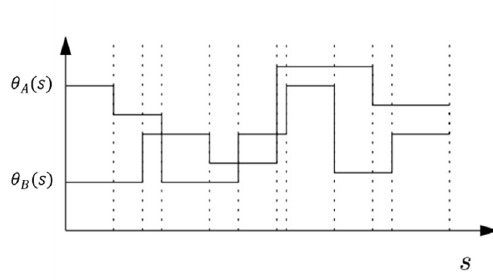
Fig. 17 Evaluation of dissimilarity with turning functions